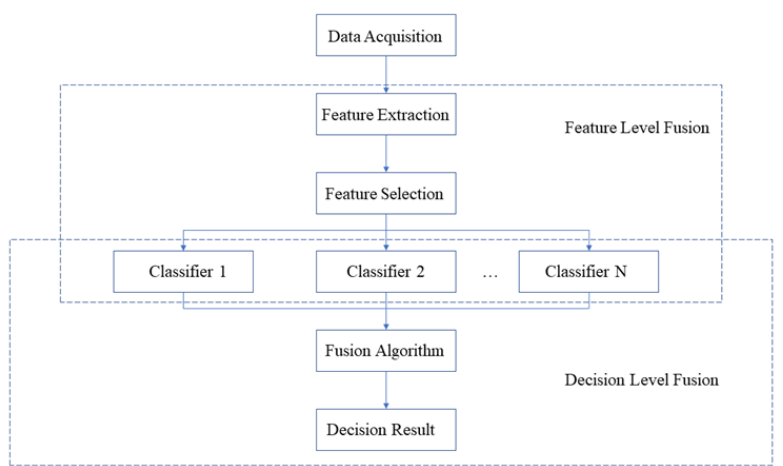
Figure 1. The block diagram of the fusion strategy. Table 1. Abbreviation and description of kinematic